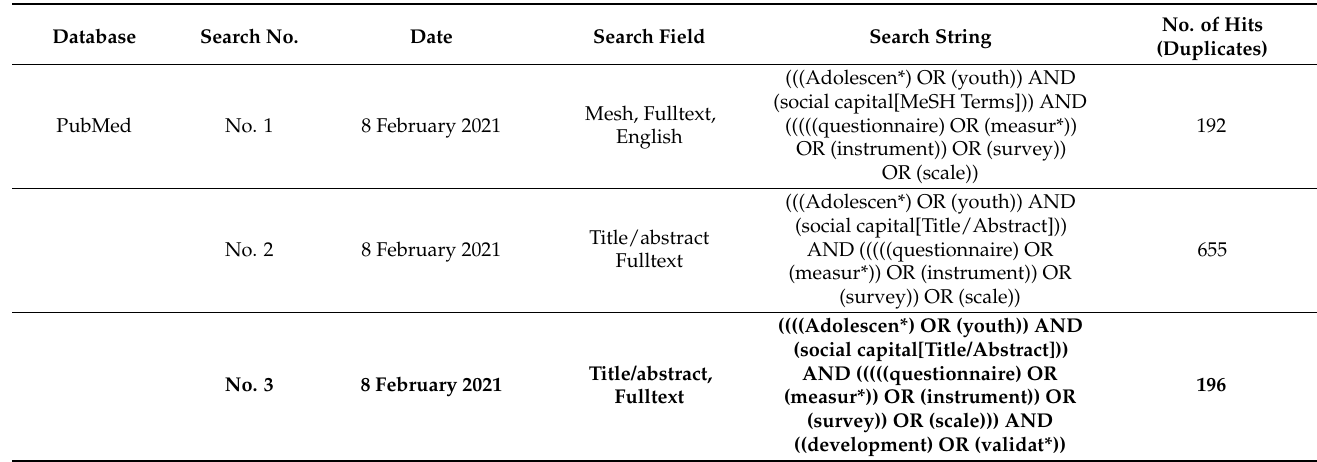
Table A1. Specifics of the systematic database